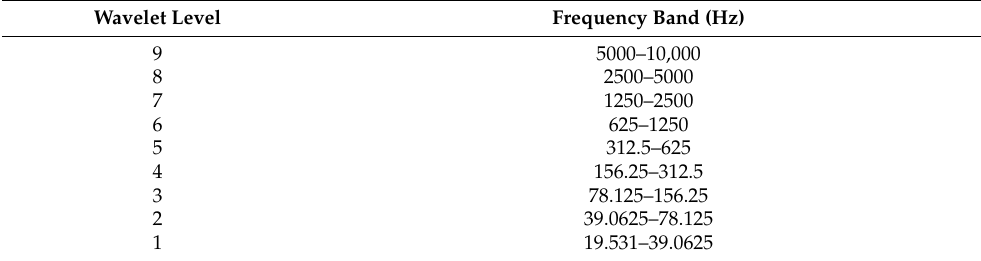
Table 2. Distribution of frequency